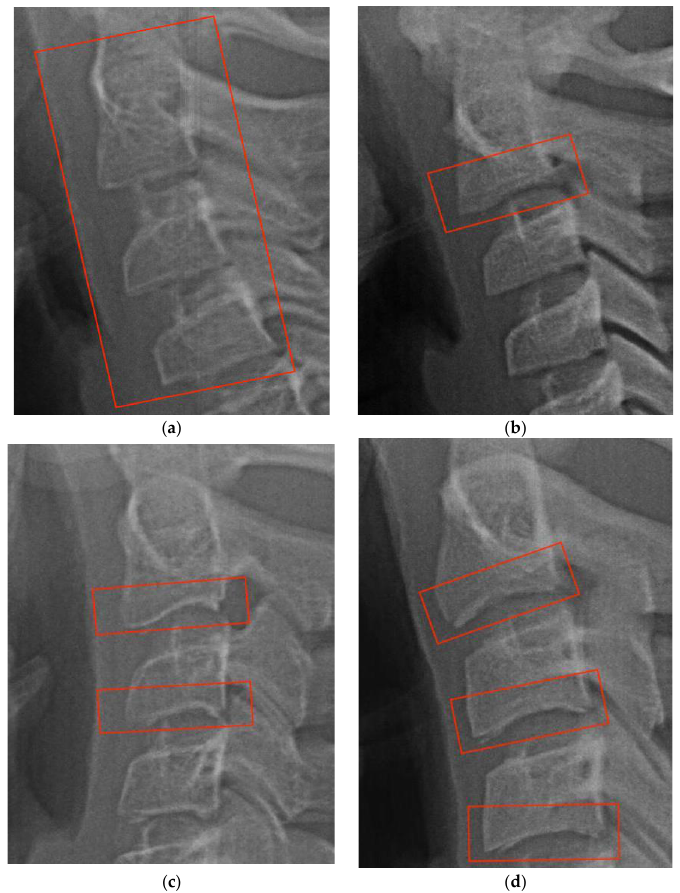
Figure 2. ( a ) The first stage. The inferior borders of the second, third, and fourth cervical vertebrae are flat and without indent; ( b ) the second stage. An indentation appeared on the inferior border of the second cervical vertebral, while the third and fourth ones are flat; ( c ) the third stage. A notch appears on the inferior border of the second and third cervical vertebrae; ( d ) the fourth stage. All three cervical bodies are indented.